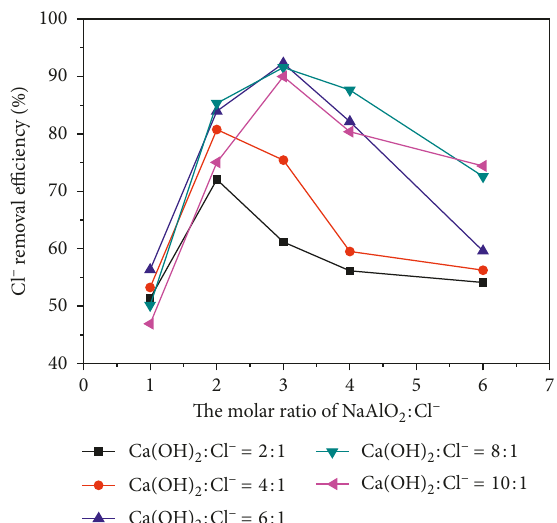
Figure 1: The effect of NaAlO